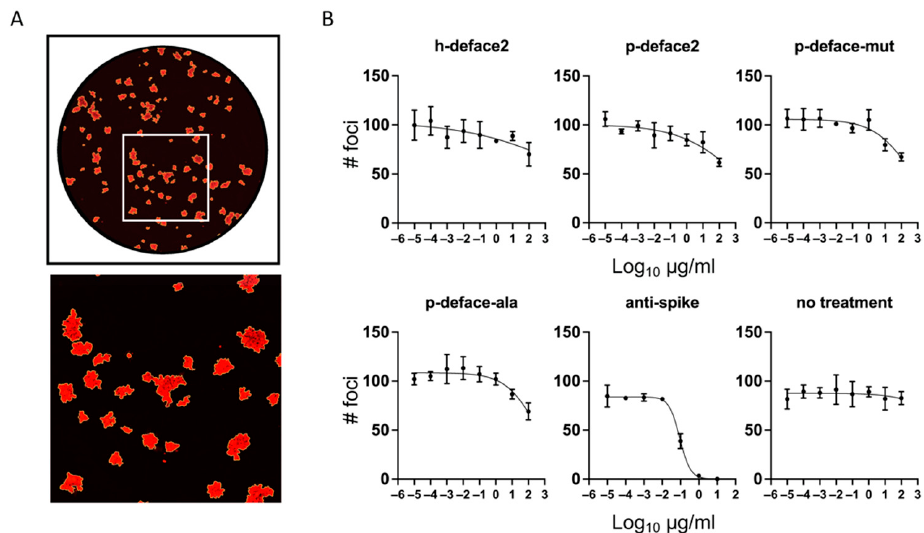
Figure 4. Mini-proteins do not neutralize infection of authentic SARS-CoV-2. Focus reduction neutralization test (FRNT) of SARS-CoV-2 (WA1 strain) on TMPRSS2-VeroE6 cells. Ten-fold dilutions of mini-proteins, alanine mutant negative control, anti-spike antibody positive control, or media alone were incubated with authentic SARS-CoV-2 and used to infect cells as described in Methods. ( A ) Representative whole-well image (above) with a magnified portion (below) indicated by the square. ( B ) Graphs and best-fit curves of the number of foci counted by Incucyte S3 software. Graphs show the mean and SD of the assay run in triplicate. NT50 and SEM of best-fit curves are displayed in Table 3. Table 3. Half maximal virus neutralizing concentrations (NT50) and SEM from best-fit curves from focus reduction neutralization test (FRNT) of authentic SARS-CoV-2 described in Figure 4.